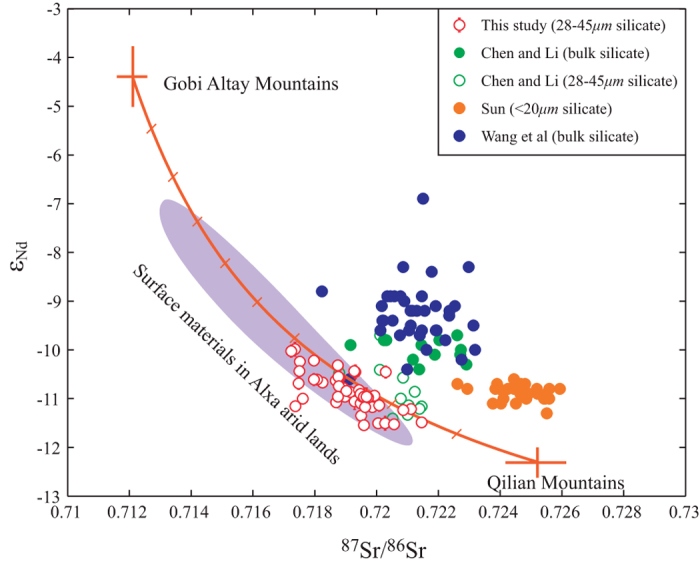
Cross plot between the silicate Nd and Sr isotopic compositions of eolian dust on the Chinese Loess Plateau. The average isotopic compositions of the two endmembers and isotopic ranges of the materials in the Alxa arid lands are based on <75 μm silicate fraction1113. The mixing line is in 10% steps. Also shown are the Nd and Sr isotopic compositions of Jingchuan section25 and Lingtai section1426.